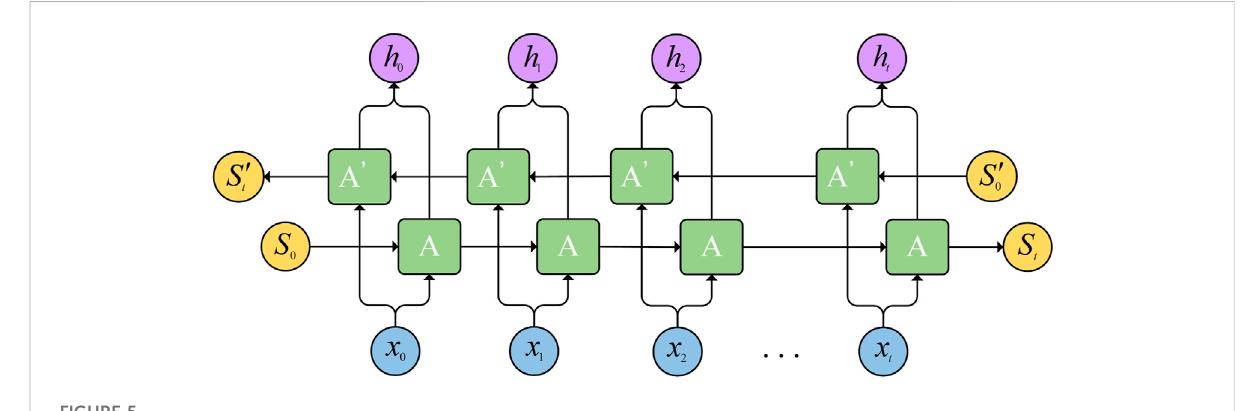
FIGURE 5 BI-LSTM